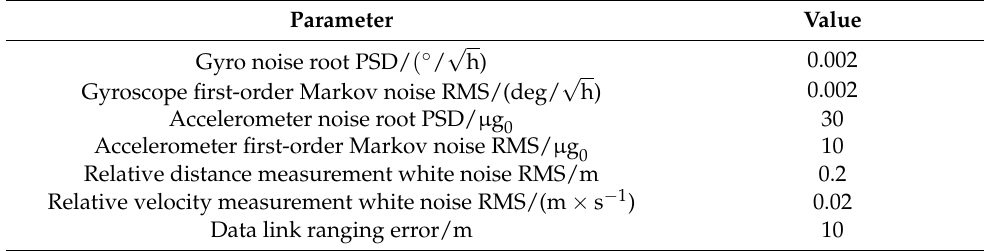
Table 2. Main parameters of INS and relative ranging and velocity sensor.